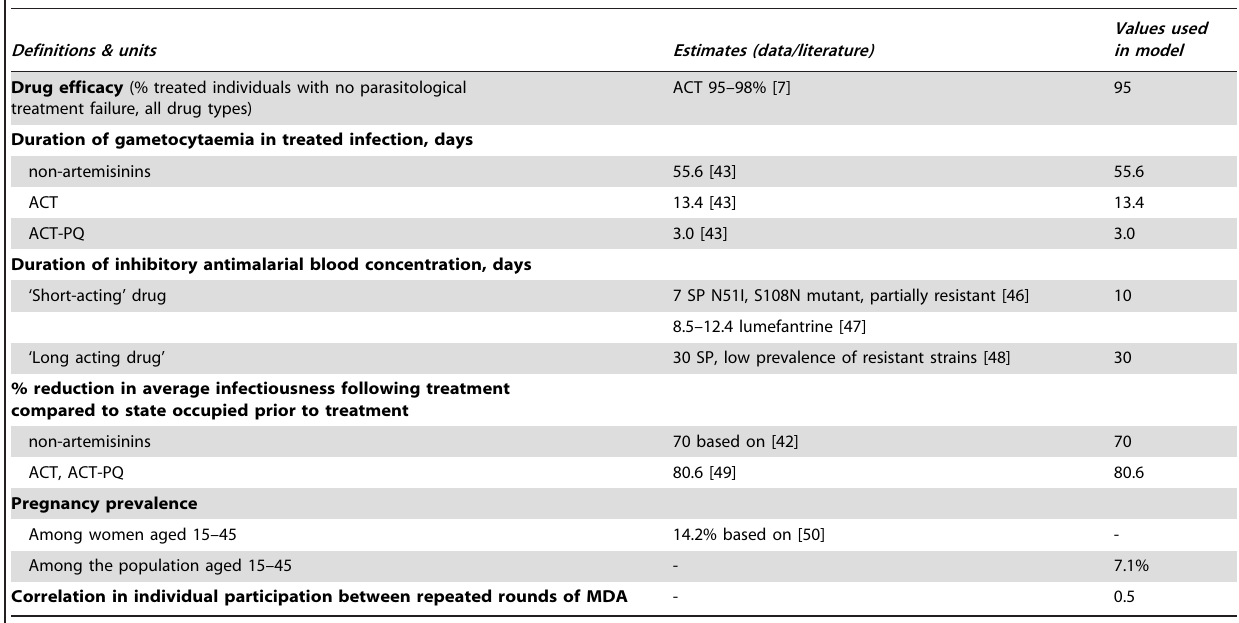
Table 1. Key parameters used in the model with